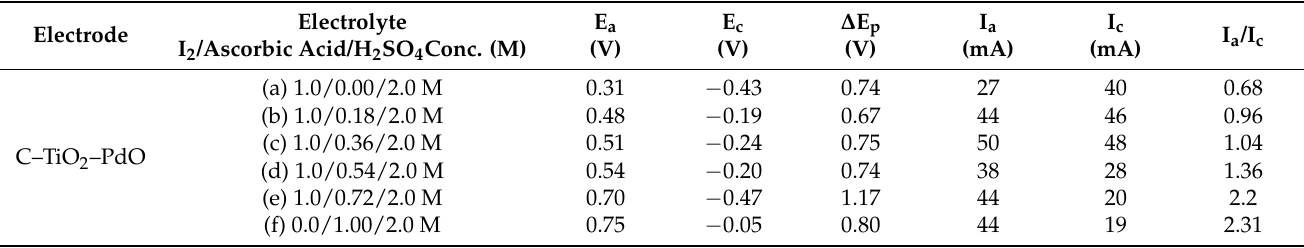
Table 3. Electrochemical characteristics of I 2 /ascorbic acid/H 2 SO 4 solution on C–TiO 2 –PdO composite electrode with 2.0 M H 2 SO 4 as a supporting electrolyte.